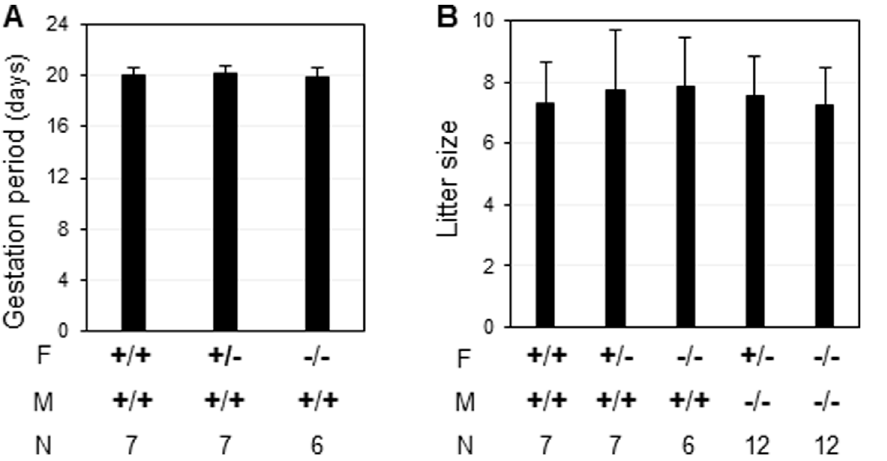
Figure 4. Deletion of Npl on gestation periods (days) from females with different genotypes crossed with wild type males (A), and litter sizes (B). + / + , wild type; + / 2 , Npl ( + / 2 ) ; 2 / 2 , Npl ( 2 / 2 ) ; F, female; M, male; N, the number of female mice in each group; error bars, standard deviation. compared to that in the pseudopregnant mouse uterus at 22:00 h suggesting that downregulation of Npl might contribute to the on D3.5 (data not shown), right before embryo attachment to the LE for implantation indicated by blue dye reaction [26],